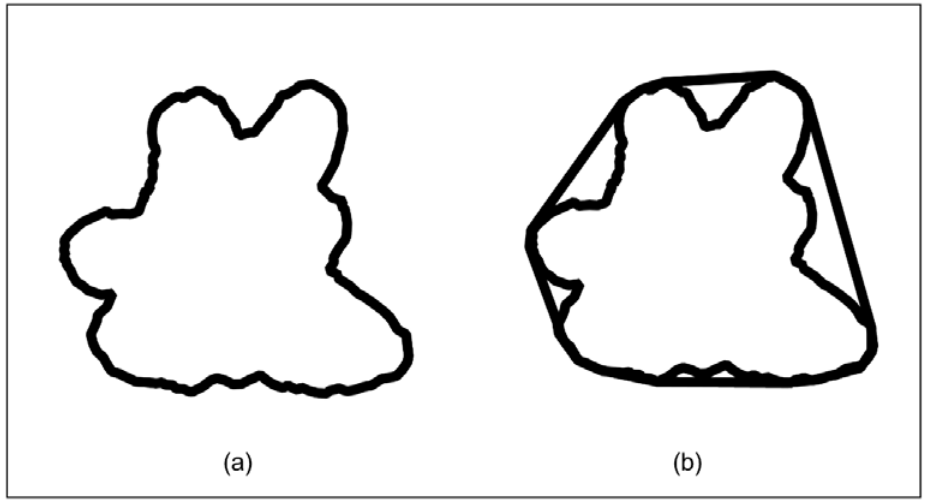
Figure 4. A stem cross-section reconstructed from a sparse point cloud. Type 1 (C 1 ) and Type 2 (C 2 ) circumferences are convex hulls based on the shortest distance between any two vertices ( a ) and a straight line between the closest outermost vertices ( b